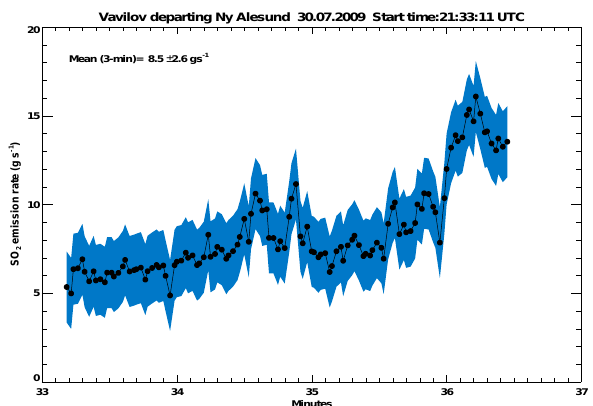
Fig. 9. SO 2 emission rate for the SS Vavilov . The shaded region (in blue) represents the standard deviation of measurements averaged FIGURE 9. SO 2 emission rate for the SS Vavilov. The shaded region (in blue) represents the standard over ∼ deviation of measurements averaged over (cid:24) 1 s.